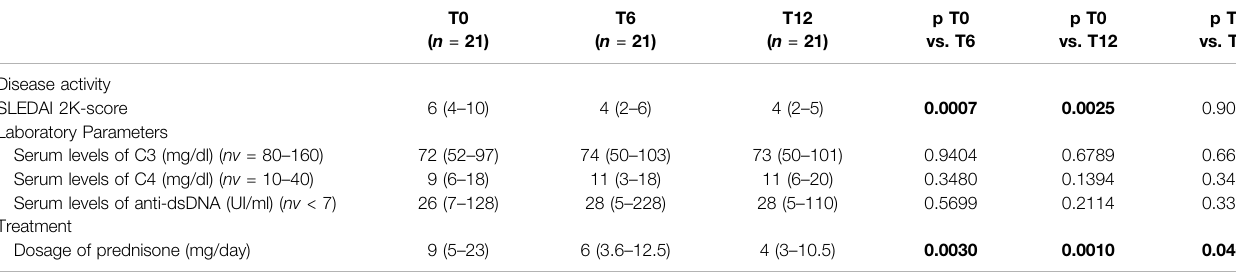
TABLE 2 | Comparisons of the clinical and laboratory features of 21 SLE patients at different time points.